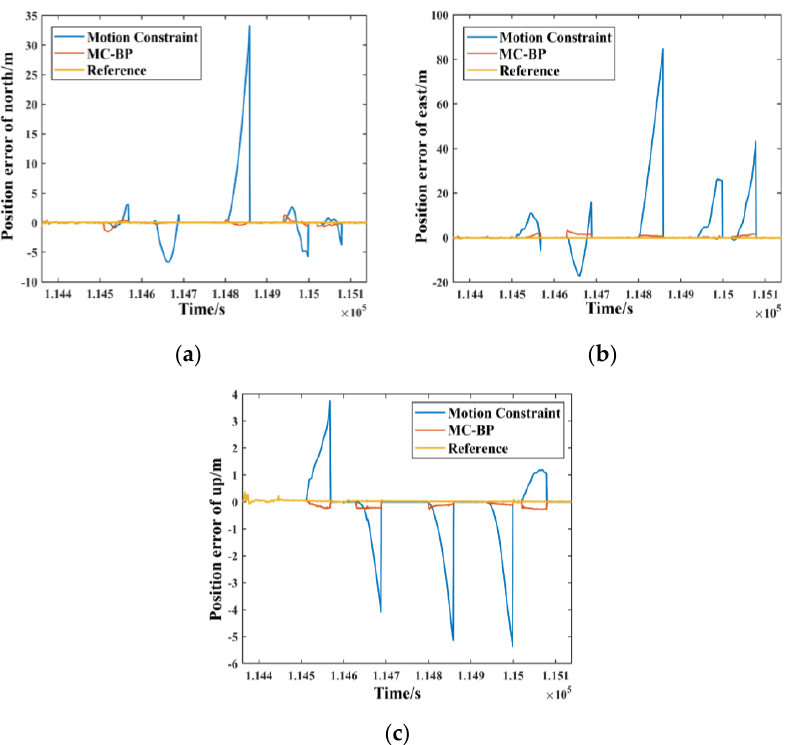
Figure 11. Vehicle land experiment ’ s positioning errors of motion constraint algorithm (Motion Constraint) and MC-BP algorithm: ( a ) north direction; ( b ) east direction; ( c ) up direction.